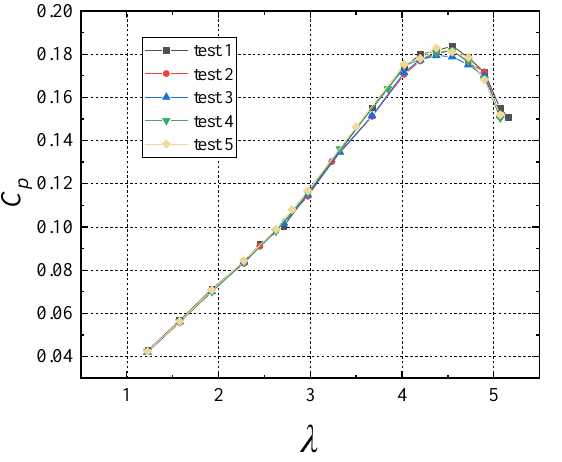
Figure 8. Verification of the test repeatability of the wind turbine with swept blades at 7 m/s. The wake field in the test was measured by a two-dimensional hot-wire anemometer probe (55P61, Dantec Dynamics A/S, Copenhagen, Denmark) with an accuracy of 0.001 V and relative error less than 0.1%. Similar to Li et al., the hot-wire was used to measure the wind turbine wake under different conditions [33].